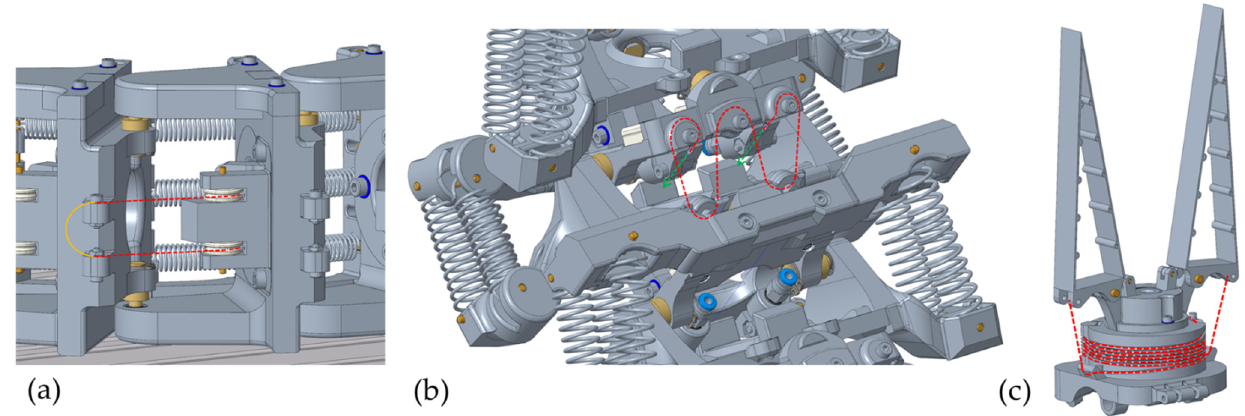
Figure 5. ( a ) Roll joint assemblies in the lower area. ( b ) Pitch joint assemblies in the middle area. ( c ) Fin Ray gripper on the end effector. The SMA wire actuators are shown as red dashed lines.